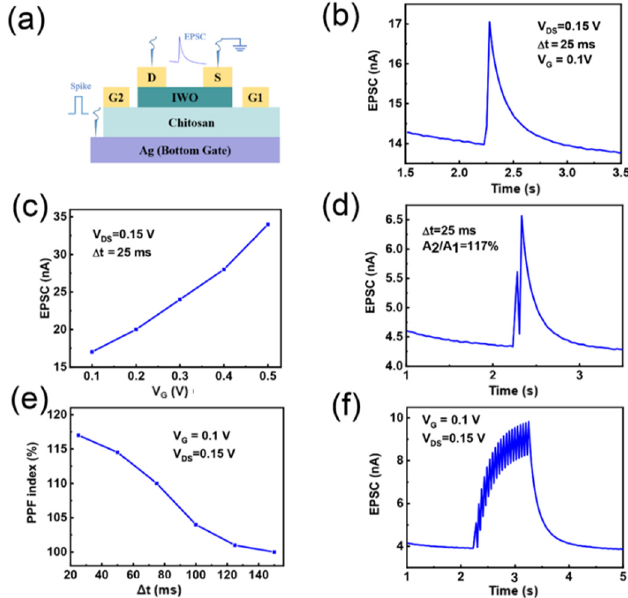
Figure 6. ( a ) Schematic of a flexible IWO-based TFT for realizing synaptic bionics; ( b ) The excitatory postsynaptic current (EPSC) triggered by a single pulse (0.1 V, 25 ms); ( c ) The maximum EPSC response current under different V G ; ( d ) The paired-pulse responses triggered by paired-pulses (0.1 V, 25 ms); ( e ) The PPF index (A2/A1) as a function of the interval time ∆ t; ( f ) The EPSC response current triggered by 20 consecutive pulses (0.1 V, 25 ms) with a frequency of 20 Hz.